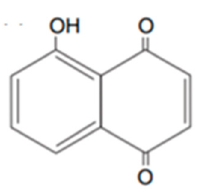
Figure 2. Representative structure of juglone.